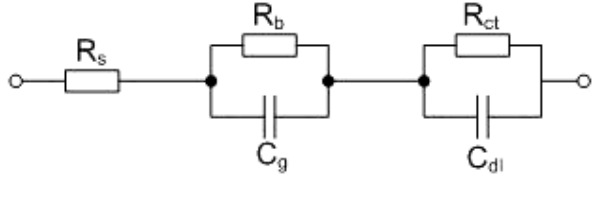
Figure 6. Equivalent circuit employed to fit the experimental EIS